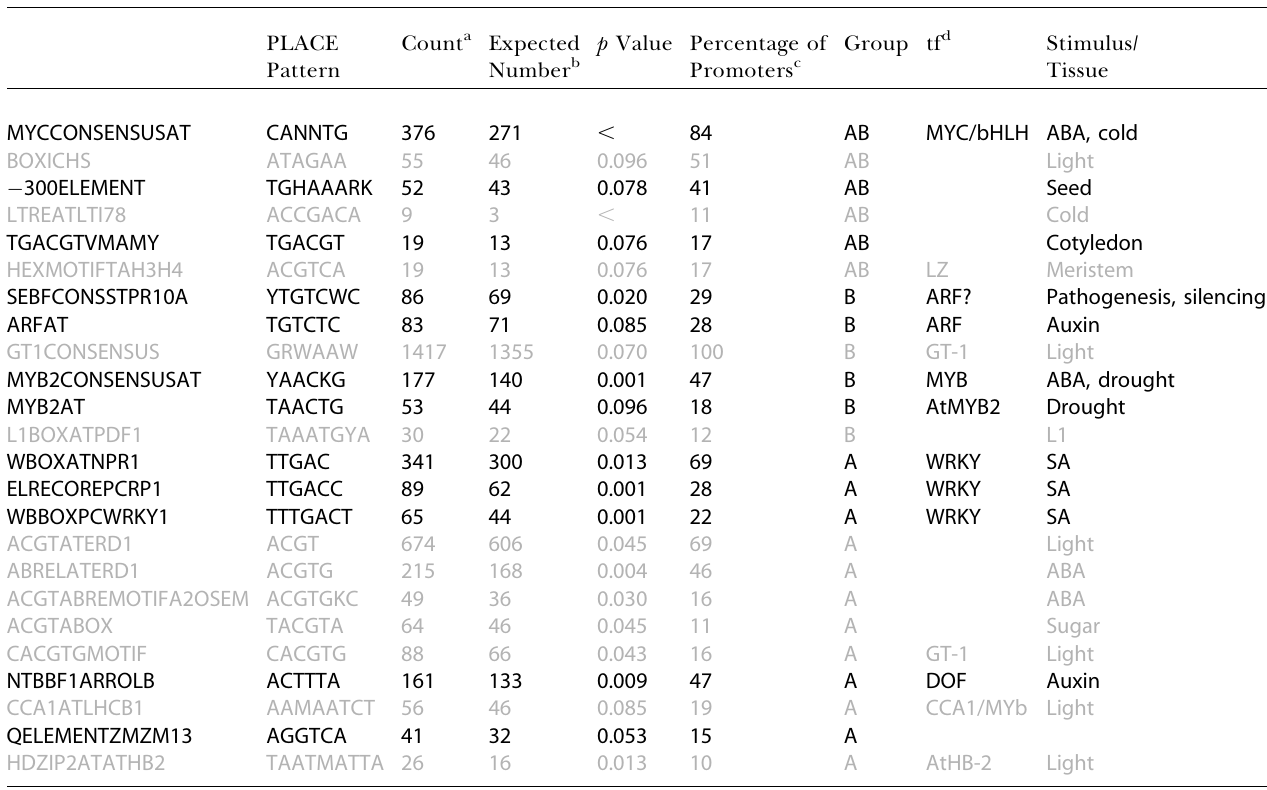
Table 1. PLACE Motifs Enriched Specifically in AB, A, or B Promoters